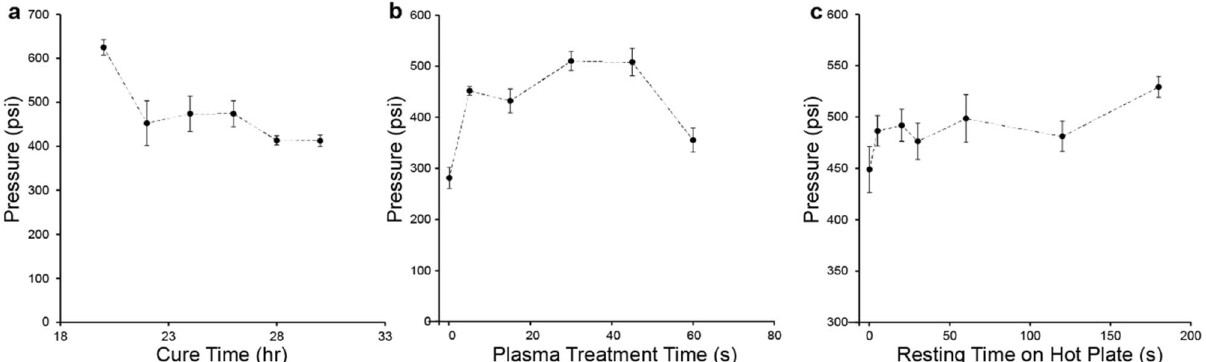
Figure 3. Optimization of bond strength. Bond strength versus ( a ) cure time, ( b ) duration of plasma treatment, and ( c ) time the device rests on a hot plate after plasma treatment. Pressures range from 650 to 240 psi.